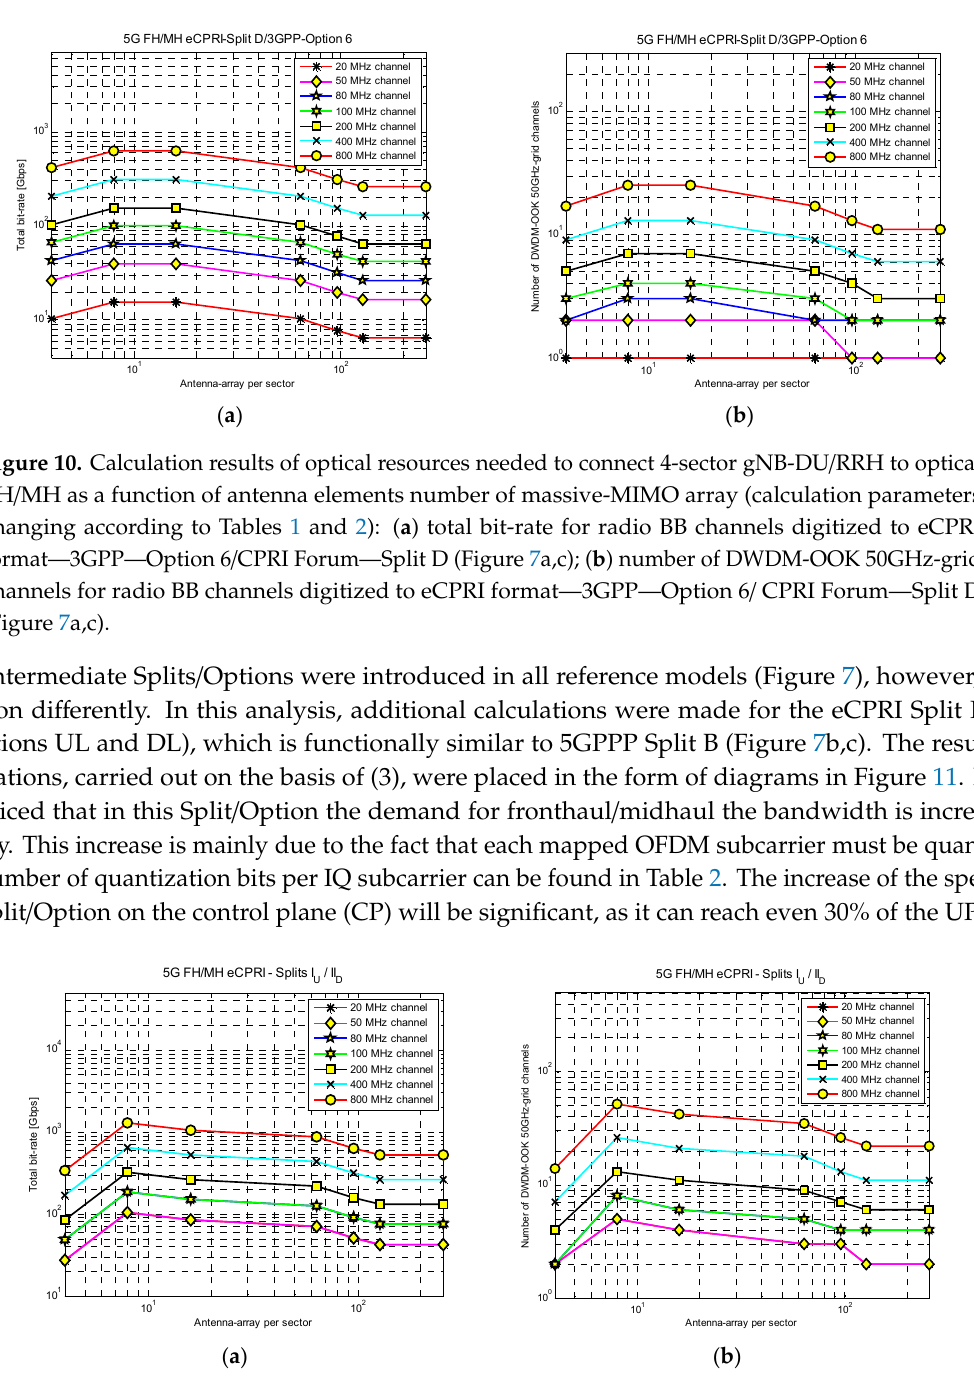
channels for radio BB channels digitized to eCPRI format—3GPP—Option 6/ CPRI Forum—Split D (Figure 7a,c). Table 2. Additional parameters of FH/MH radio streams for calculation of bandwidth consumption in the lower Split/Option interfaces [29,32,51]